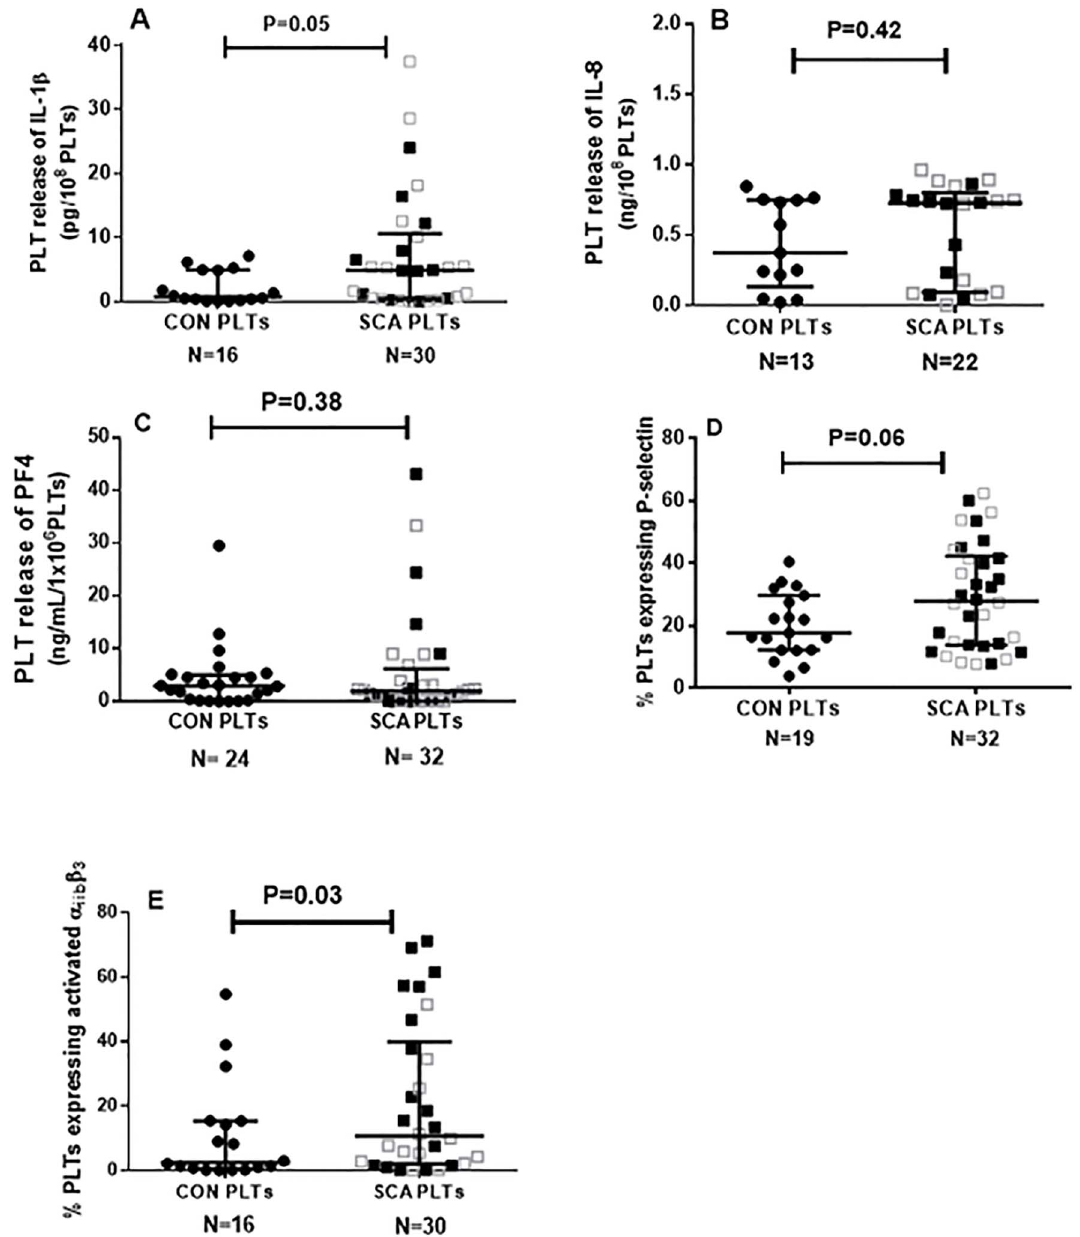
Figure 1. Platelets as inflammatory cells in SCA. Release of (A) IL-1 b , (B) IL-8, (C) platelet factor 4 (PF4) from platelets of healthy control individuals (CON) and SCA patients in steady state (SCA). Cytokine release was determined by ELISA in platelet suspensions (1 6 10 8 PLT/ml) after incubation for 4 h (37 u C, 5% CO 2 ). Expressions of (D) P-selectin and (E) activated a IIb b 3 integrin on the surface of platelets from healthy control individuals (CON) and SCA patients in steady state (SCA). Medians and interquartile ranges are depicted. Adhesion molecule expression